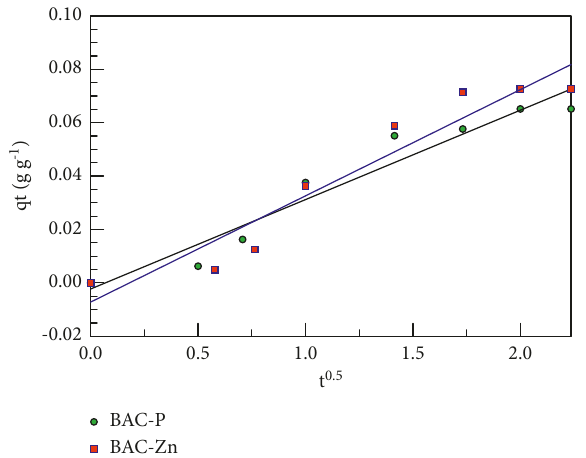
Figure 19: Boyd plot for adsorption of 1g L − 1 Cu(II) ions onto the BAC-P and BAC-Zn